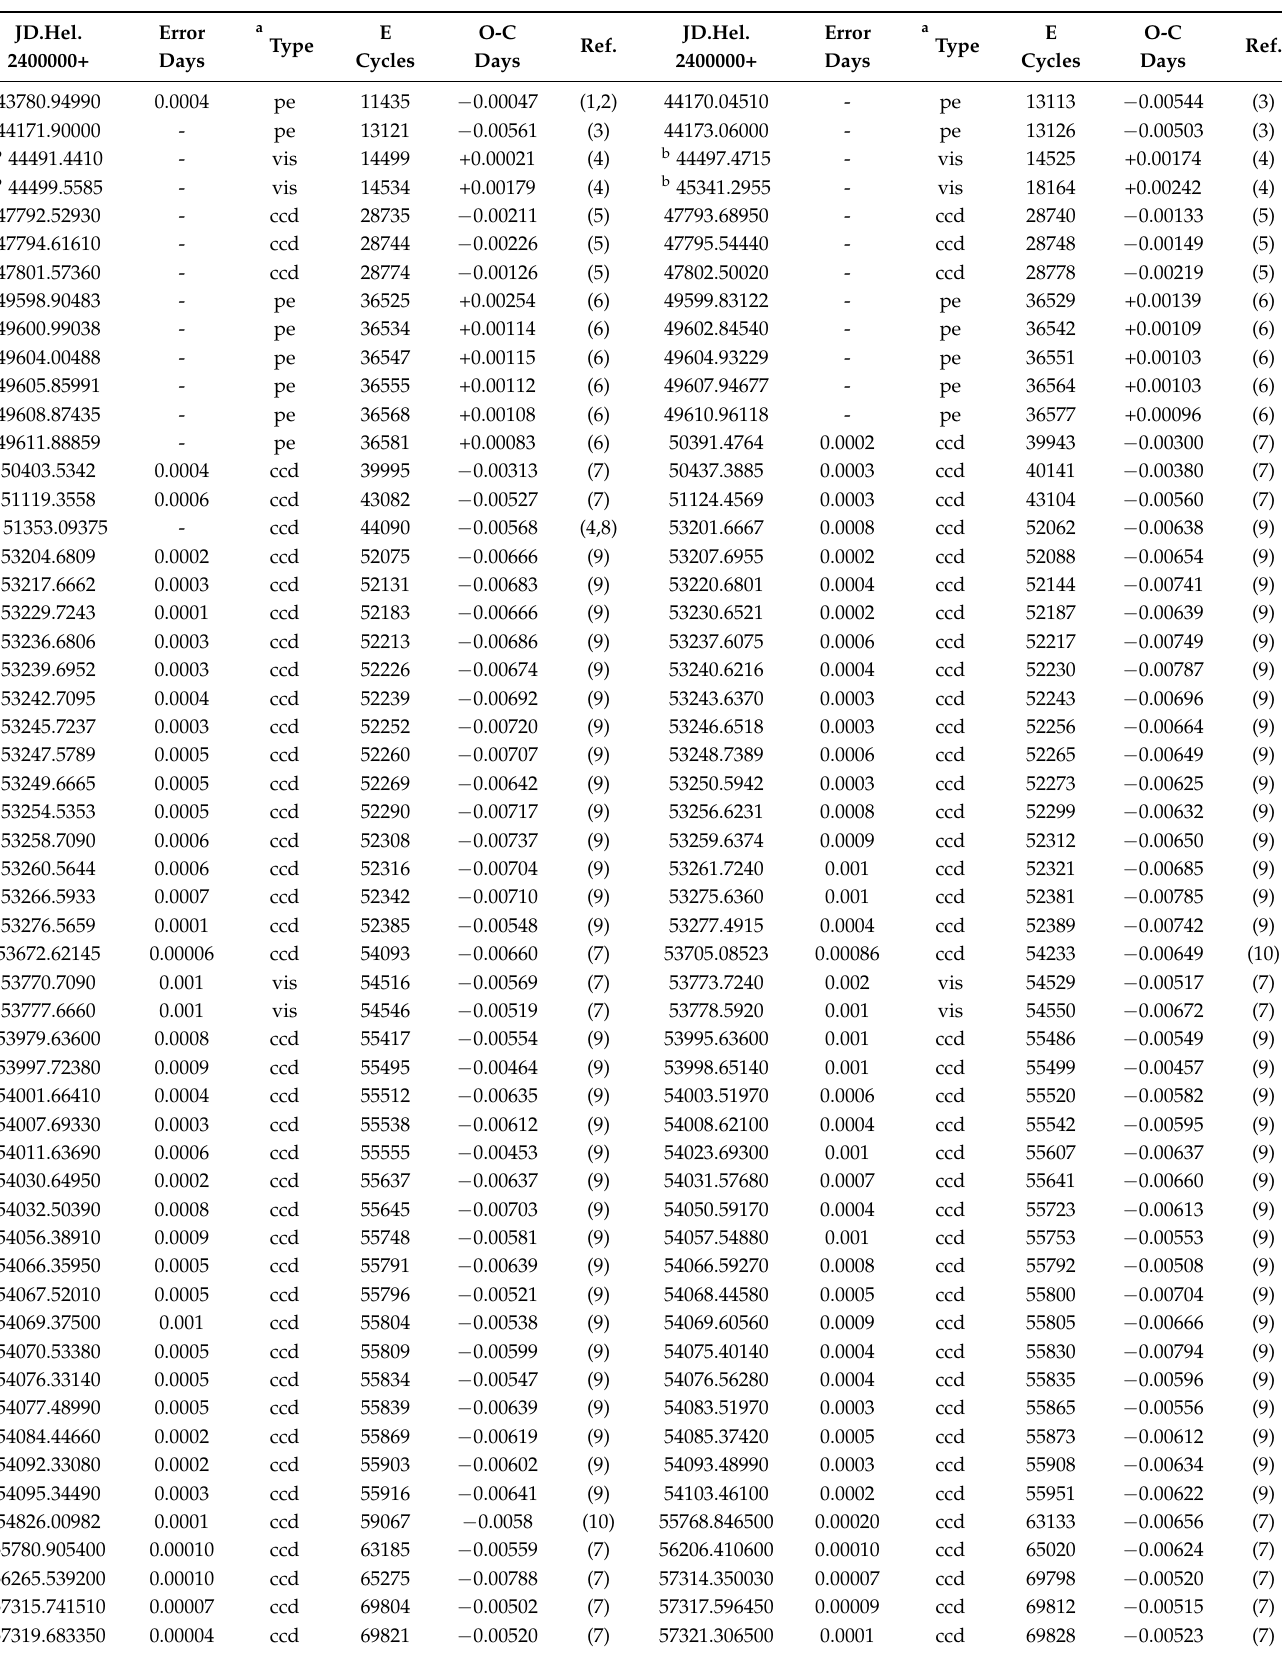
Table A2. New light minimum times of RW